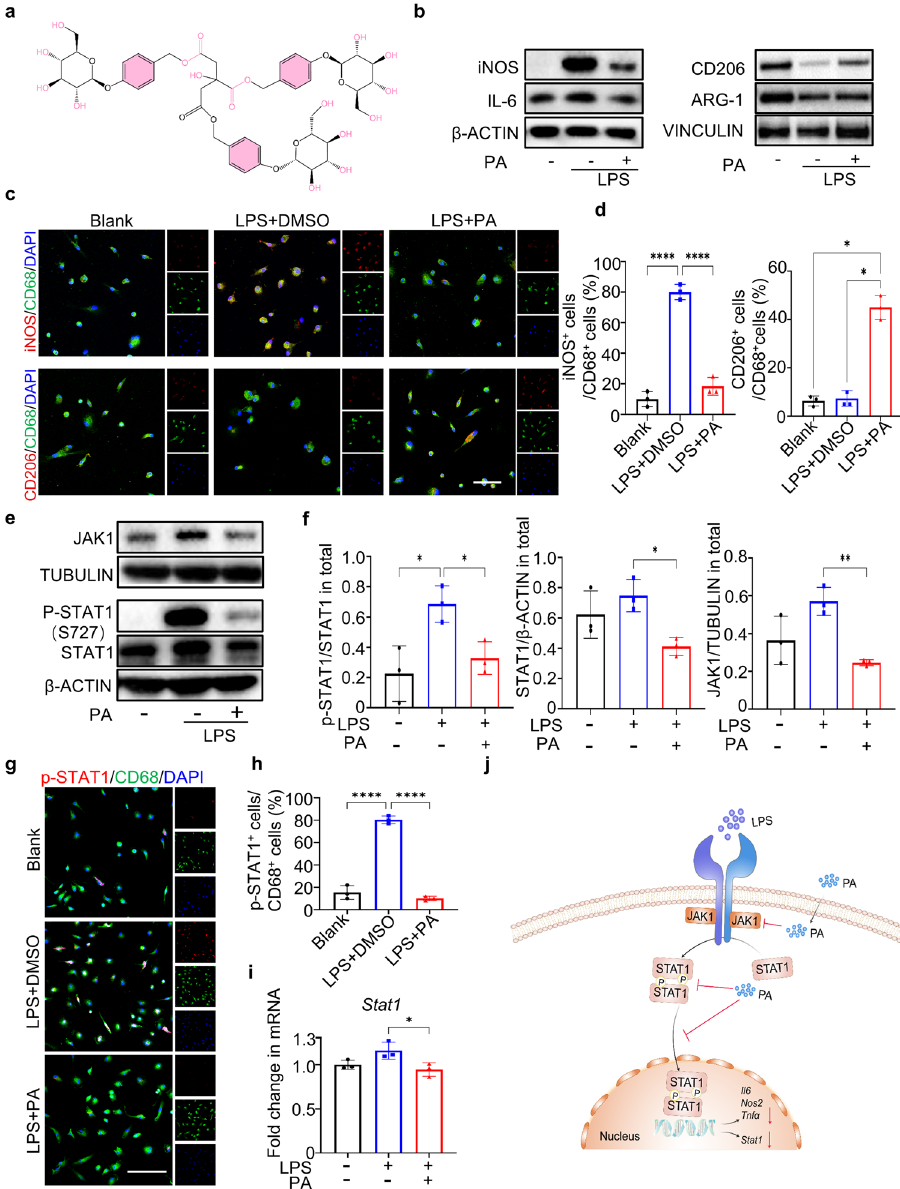
Fig. 1 PA promotes M2 macrophage polarization through JAK/STAT1 pathway. a Molecular structure of the small-molecule compound PA. b Western blotting of iNOS, IL-6, CD206 and Arg-1 in DMSO- and PA-treated rat BMDMs under LPS stimulation. c Co-immuno fl uorescence staining for iNOS/CD68 and CD206/CD68 in unstimulated BMDMs and DMSO, PA-treated BMDMs under LPS stimulation. Scale bar, 50 μ m. d Semi-quanti fi cation of c . e Western blotting of total JAK1, phosphorylation of STAT1 and total STAT1 in DMSO- and PA-treated BMDMs under LPS stimulation. f Semi-quanti fi cation of ( e ). g Immuno fl uorescence staining of p-STAT1 in DMSO- and PA-treated BMDMs under LPS stimulation. h Semi-quanti fi cation of ( g ). i RT-PCR of Stat1 in expression in DMSO- and PA-treated BMDMs under LPS stimulation for 15 min. Scale bar, 50 μ m. j Schematic illustration of the pharmacological mechanism of PA. Data are presented as mean ± SD. * p < 0.05, ** p < 0.01 and **** p < 0.0001, n =